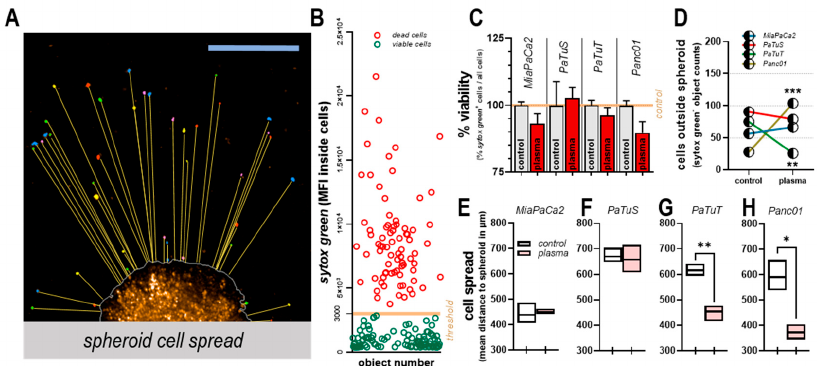
Figure 5. Plasma treatment unaffected or decreased cell detachment from tumor spheroids. ( A ) representative image of spheroid stained with DiL, and calculation of shortest distance from spheroid (yellow lines) to cancer cells spread in Matrigel extracellular matrix; ( B ) representative scatter dot blot of single cells detected outside the spheroid and the cut-off (orange bar) of sytox green mean fluorescence intensity (3 × 10 3 ) for discrimination of viable and dead cells; ( C ) % viable cell cells (normalized to untreated controls) outside the spheroid at 72 h after plasma exposure; ( D ) total live cell counts outside the spheroid at 72 h after treatment, and mean distance of these cells (viable) to the main spheroid of ( E ) MiaPaCa2, ( F ) PaTuS, ( G ) PaTuT, and ( H ) Panc01 cells. Data are mean + SEM ( C ), mean ( D ) or mean, minimum and maximum ( E – H ) of three replicates per cell line and group as representative of three independent experiments; scale bar represents 450 µ m. Cancers 2019 , 11 , x FOR PEER REVIEW